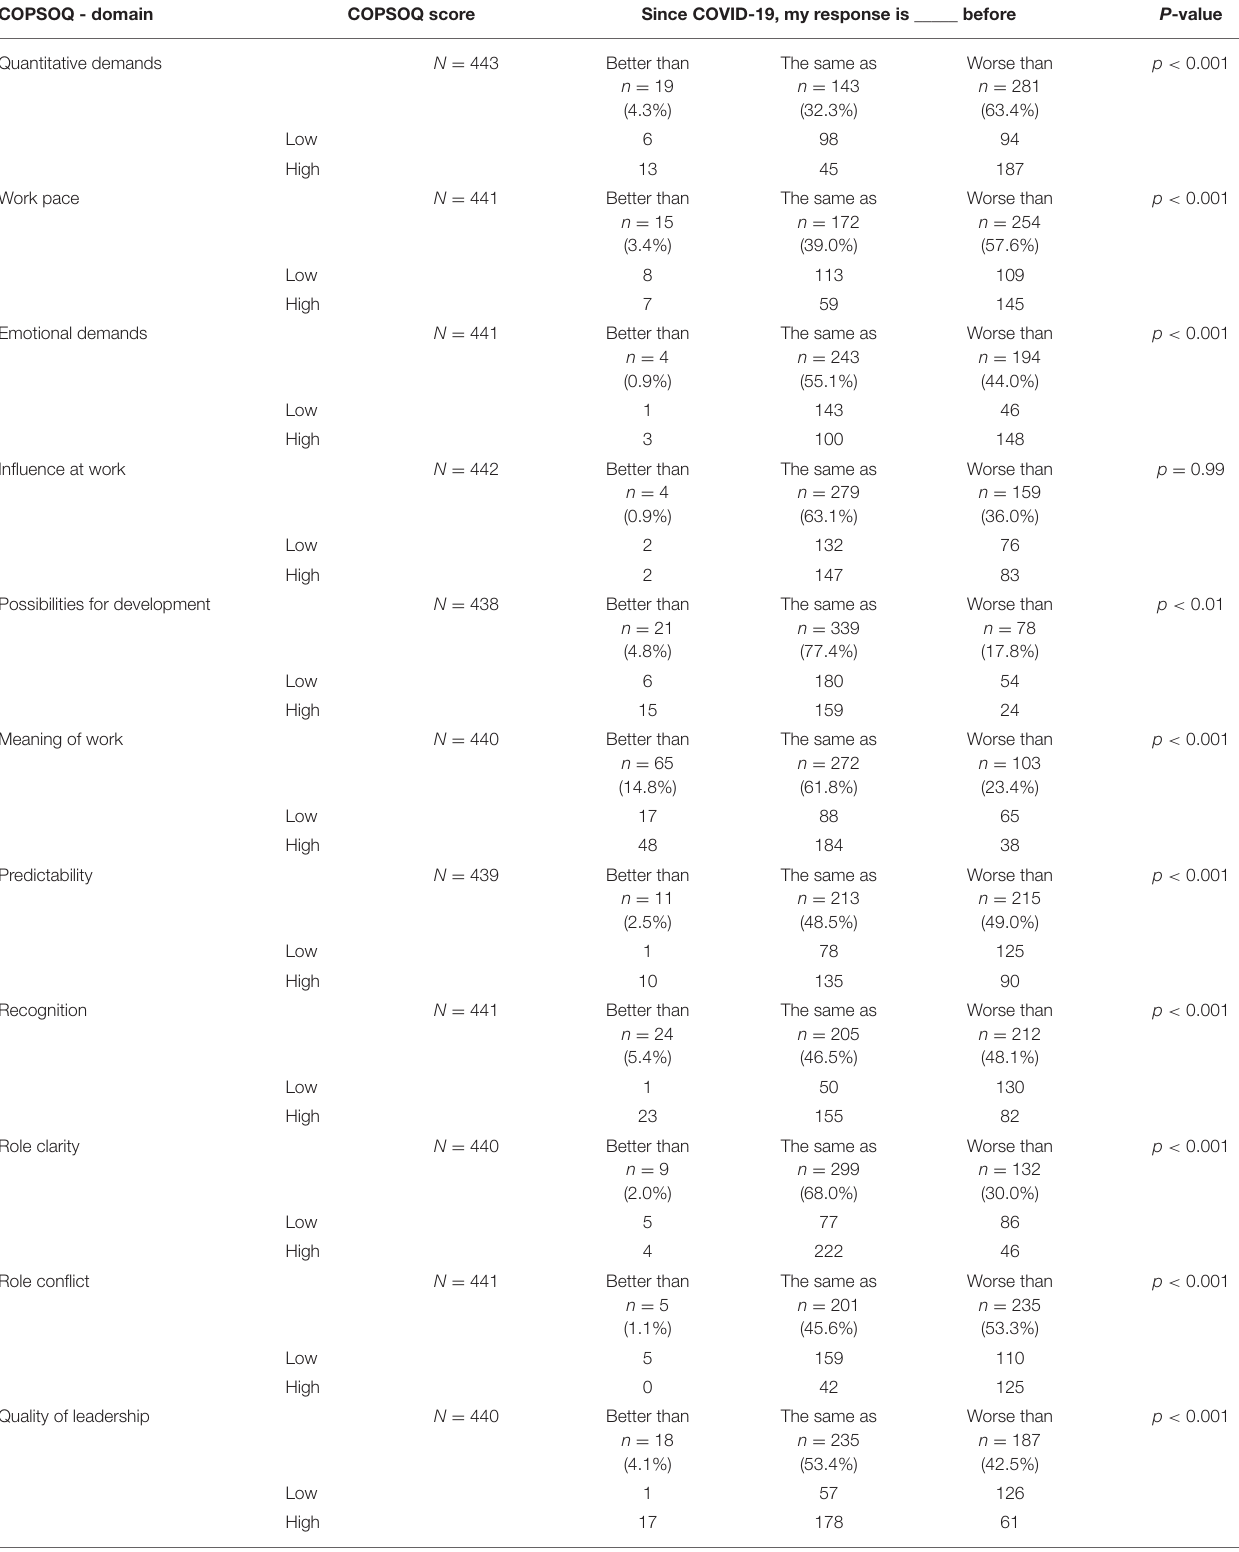
TABLE 4 | Cross-tabulation of COPSOQ-III scores and COVID-19 (medical laboratory technologists). COPSOQ -